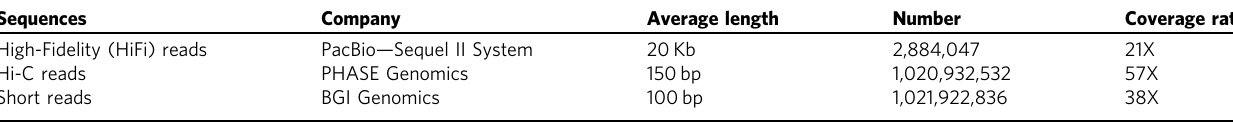
Table 1 The sequencing technologies used for generating the American mink genome